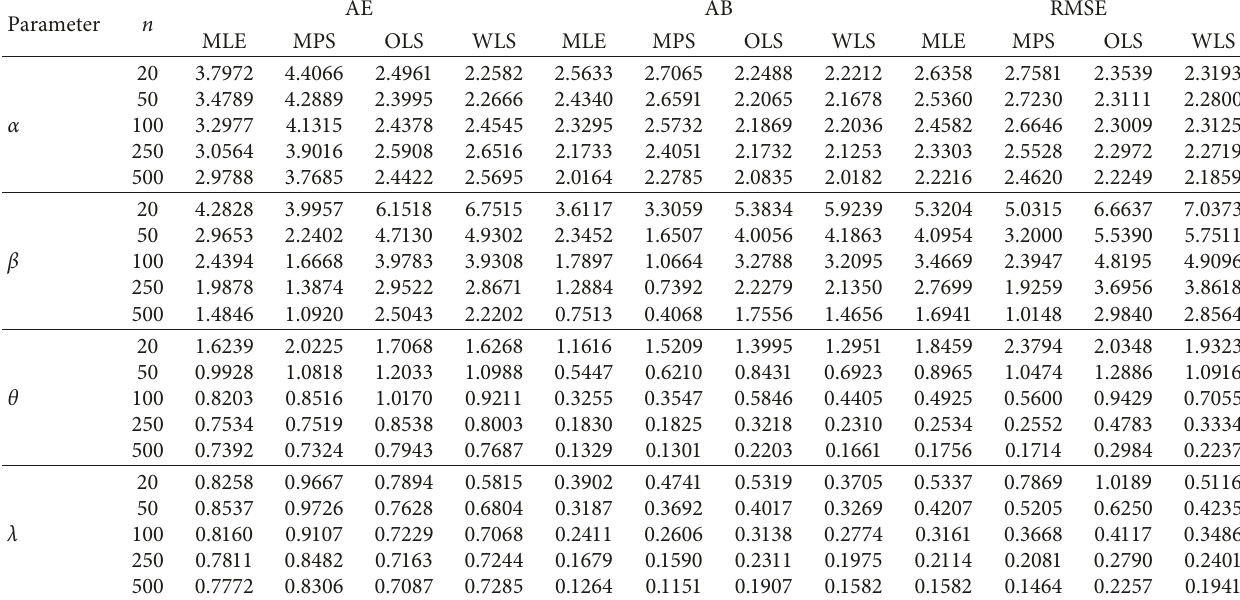
Table 3: Simulation results for II � ( α � 2 . 1 , β � 0 . 9 , θ � 0 . 7 , λ � 0 . 8 ) .